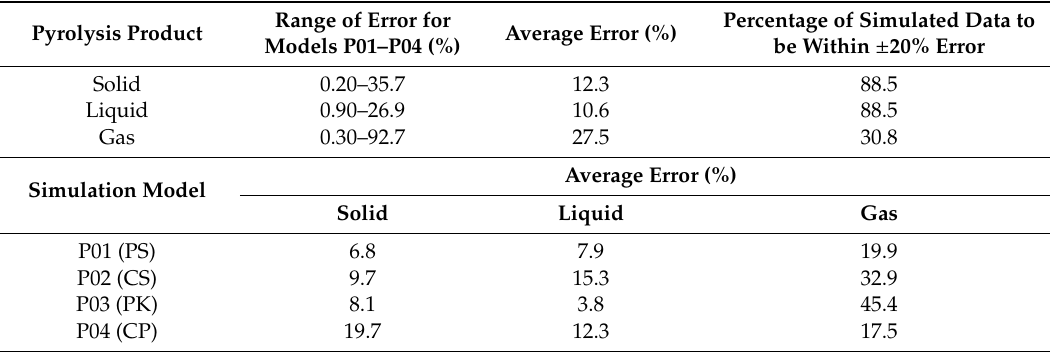
Table 6. Analysis of error of simulated results in Table